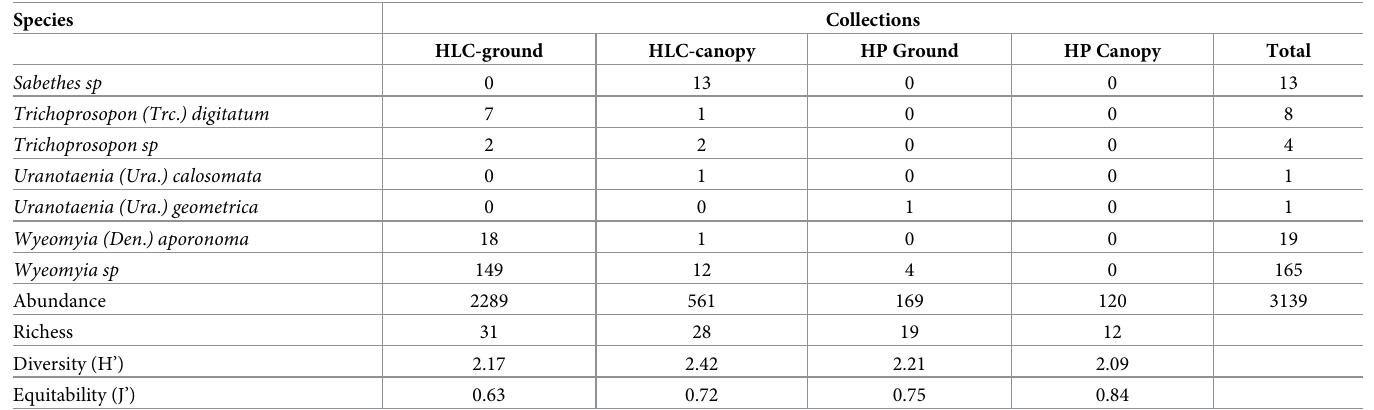
and richness were highest on the ground (Table 1). The species richness varied from 12 to 31 among the ground and canopy, and the abundance varied from 120 to 2,289 individuals (Table 1). The most abundant genera were Psorophora , with seven species and 1,219 specimens (31.8%), and Ochlerotatus with five species and 744 specimens (19.8%). The most abundant species were Ps . ferox , with 740 individuals (23.5%), Oc . serratus , with 576 (18.3%), and Ps .